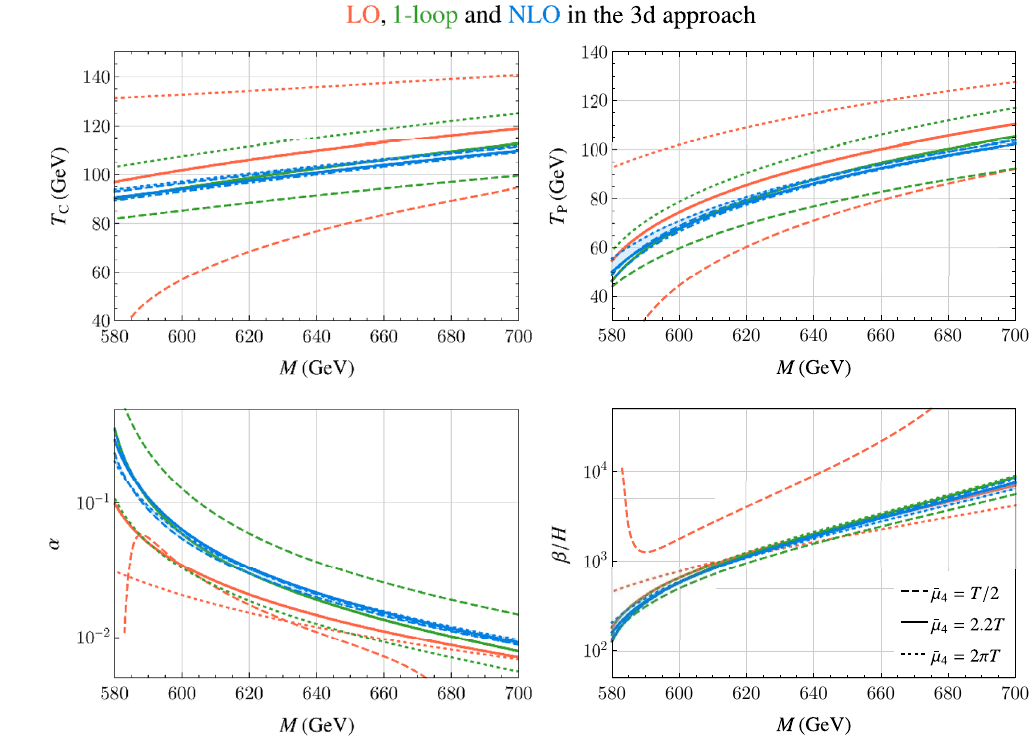
Figure 7 . Comparison of LO, 1-loop and NLO matching relations in dimensional reduction, show- ing their ¯ µ scale dependence. The LO matching relations, though gauge invariant, depend strongly on the scale. The 1-loop matching relations significantly reduce the scale dependence with respect to LO, and give an uncertainty band which is relatively constant with M . The NLO matching re- lations significantly reduce scale dependence further with respect to 1-loop. It is heartening to see that the NLO results lie entirely within the 1-loop scale uncertainty bands. The optimal ¯ µ = 2 . 2 T is established in eq.